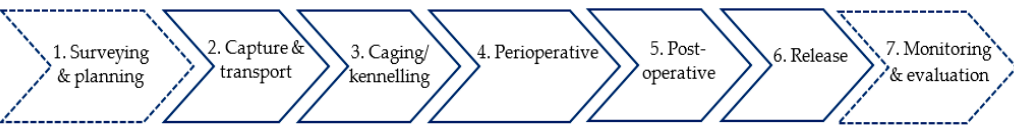
Figure 1. Flow diagram outlining the seven primary stages of CNR. Solid outline = stages that were determined to directly impact upon dog welfare.